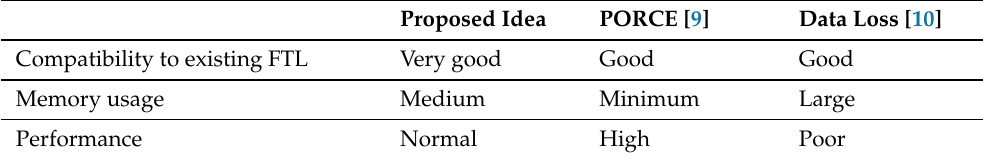
Table 1. Comparison of the proposed RSLSP with the benchmark